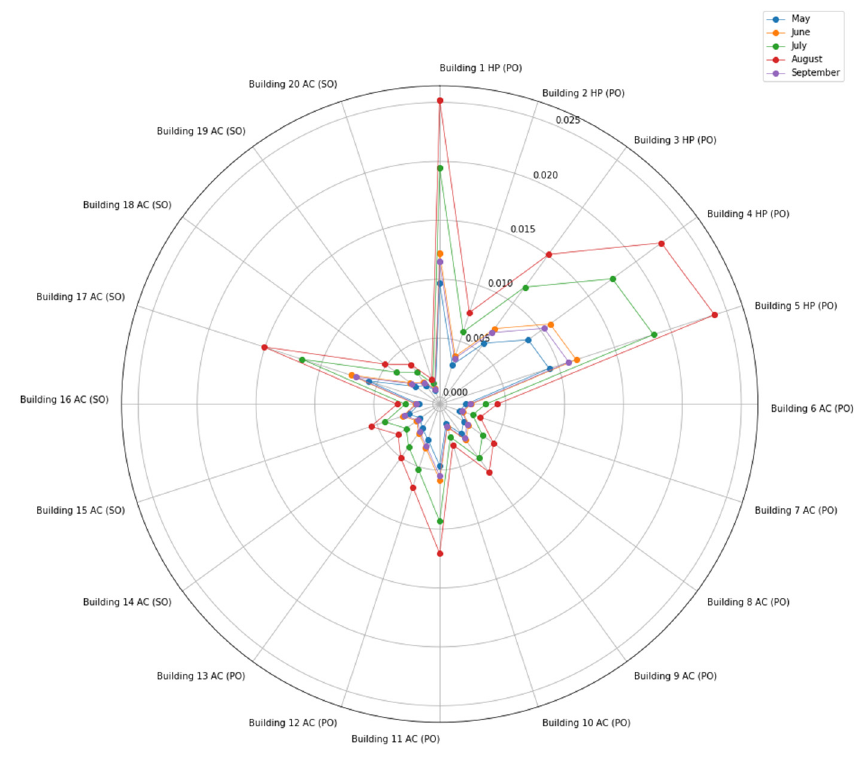
Figure 16. Energy savings obtained on an average day with 50% decrease from average consumption without DR repetitions per building.